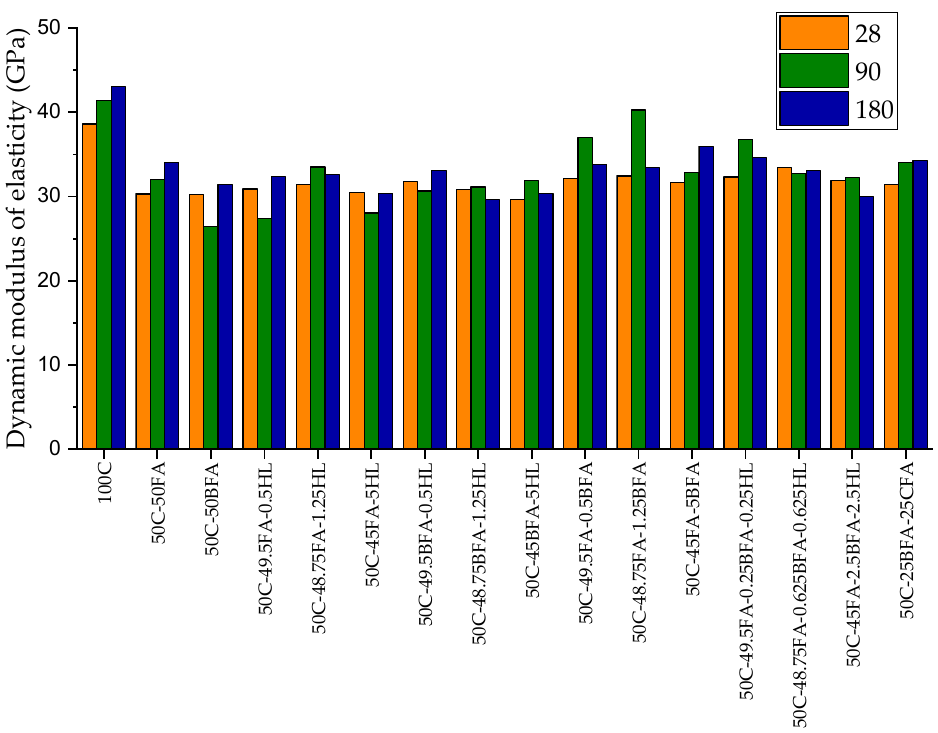
Figure 4. Dynamic modulus of elasticity for the different mortar formulations for 2, 7, 28, 56, 90, and 180 of curing.